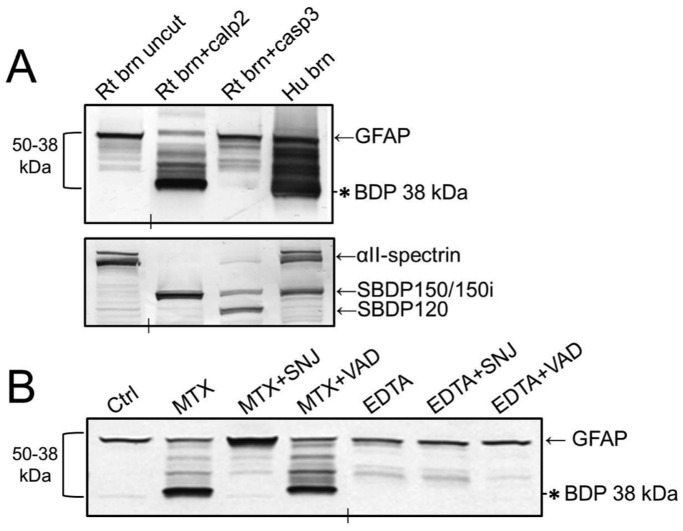
Calpain-associated GFAP breakdown occurred in vitro and in primary rat cortical cultures.
A. Rat brain (Rt brn) lysate was subjected to calpain-2 or caspase-3 digestion in vitro, blotted, and probed with antibodies against GFAP (Abcam; top panel) or αII-spectrin (Enzo; bottom panel). Calpain-2 produced a banding pattern similar to the human brain lysate, while caspase-3 did not. Enzymes produced their characteristic spectrin BDP patterns (SBDP150 for calpain, SBDP150i and SBDP120 for caspase). B. Rat CTX mixed cultures were untreated (Cntl) or subjected to the indicated drug treatments, then blotted and probed with GFAP antibody (Abcam). The calpain activator maitotoxin (MTX), but not the caspase activator EDTA, induced strong GFAP breakdown to the 38 kDa GFAP band. The calpain inhibitor SNJ1945 (SNJ), but not the caspase inhibitor Z-VAD-fmk (VAD), blocked GFAP breakdown by MTX. In A and B, vertical hash marks indicate where intervening lanes were removed. An asterisk marks the 38 kDa GFAP band throughout.